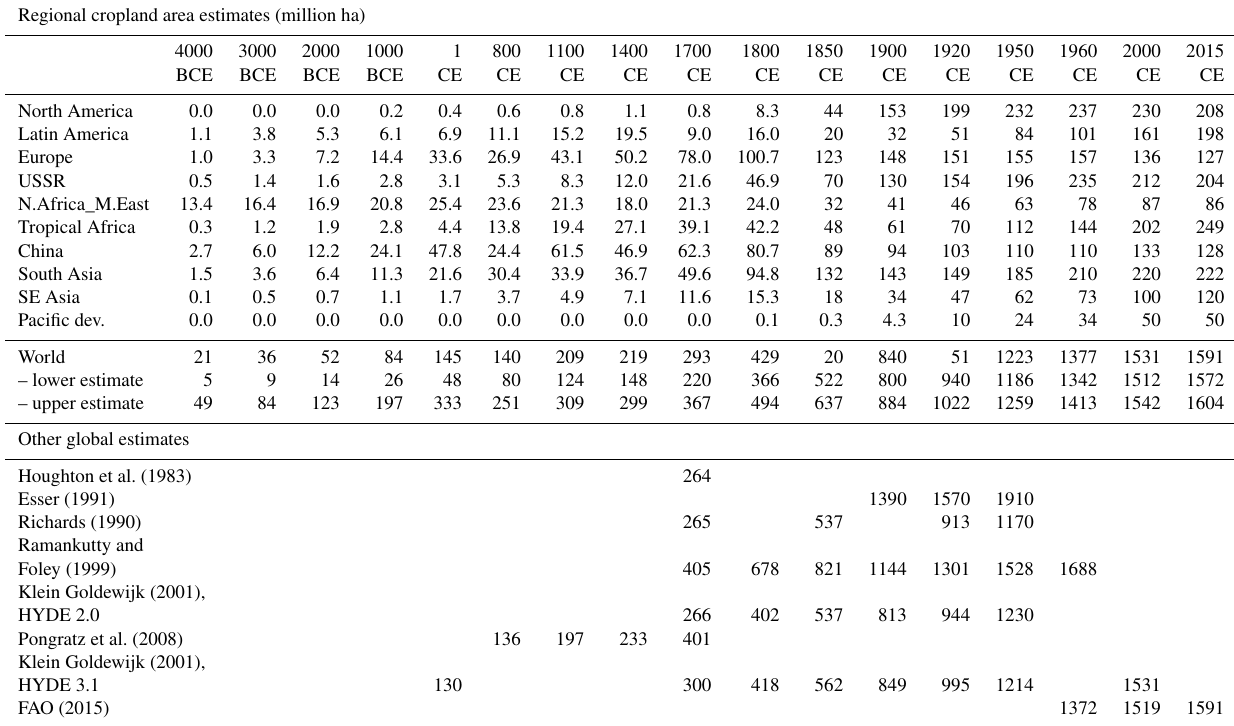
Table 2. Regional cropland area estimates (million ha).